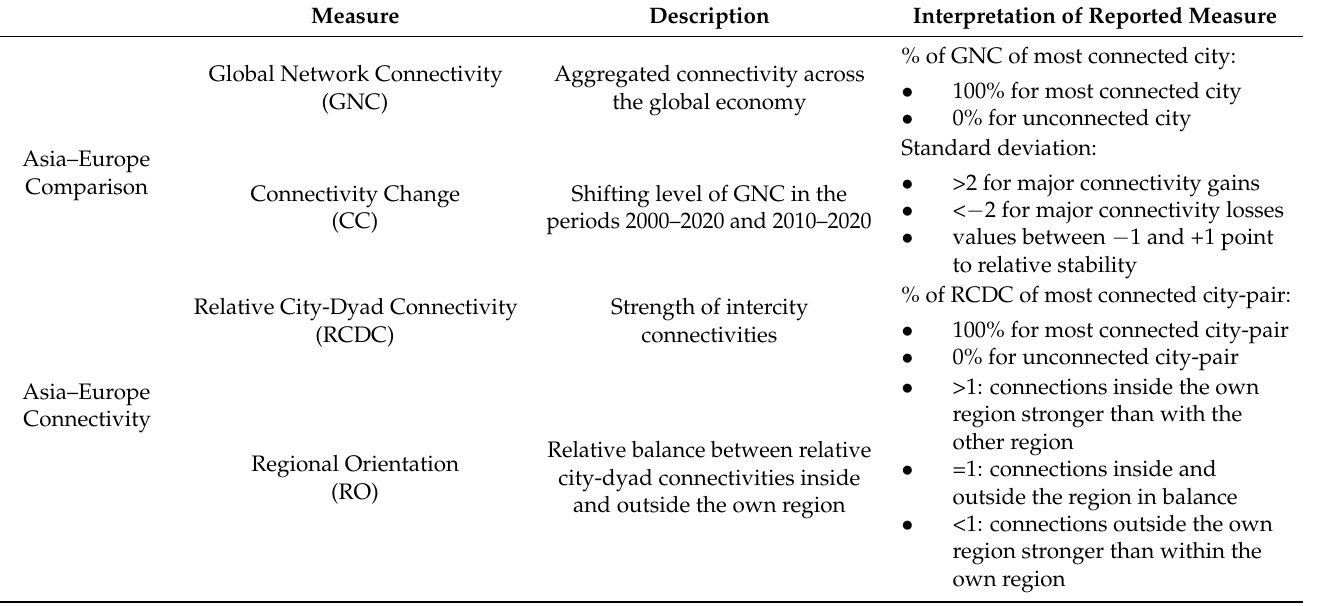
Table 1. Description and interpretation of city connectivity